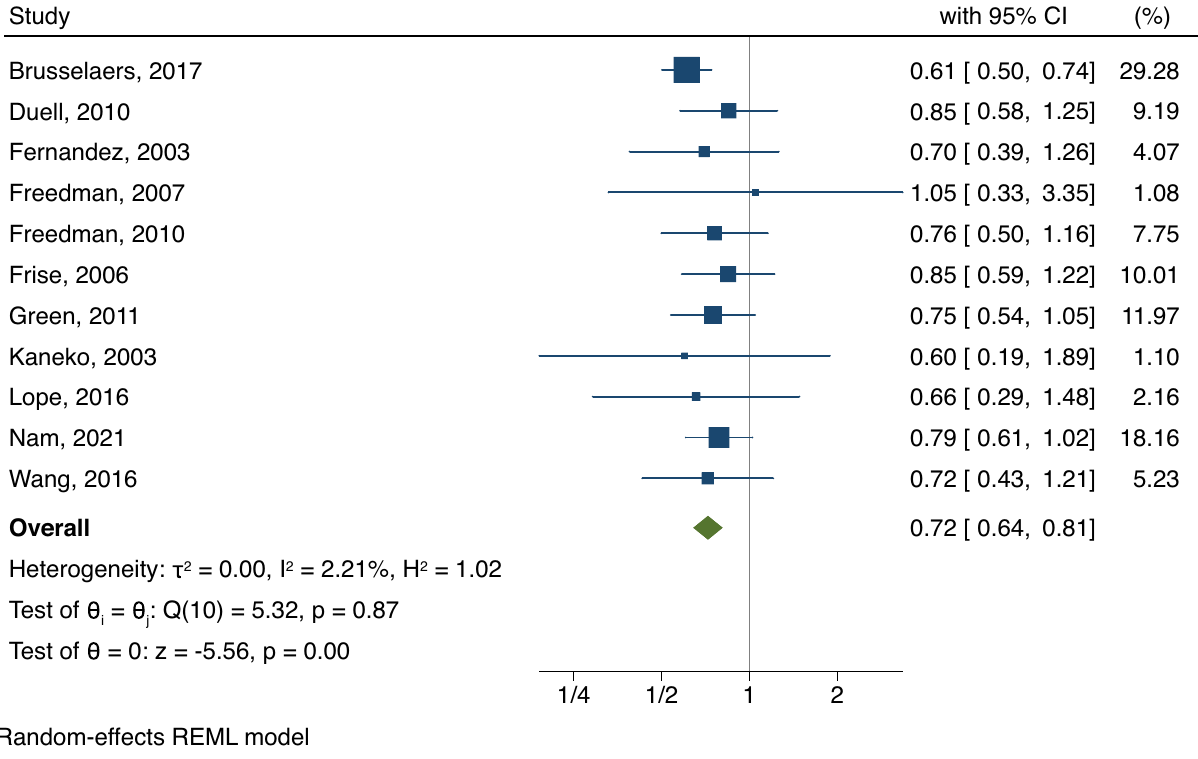
Figure 2. Summary of pooled risk estimates. The association between HRT use and risk of gastric cancer. CI confidence intervals, HRT hormone replacement